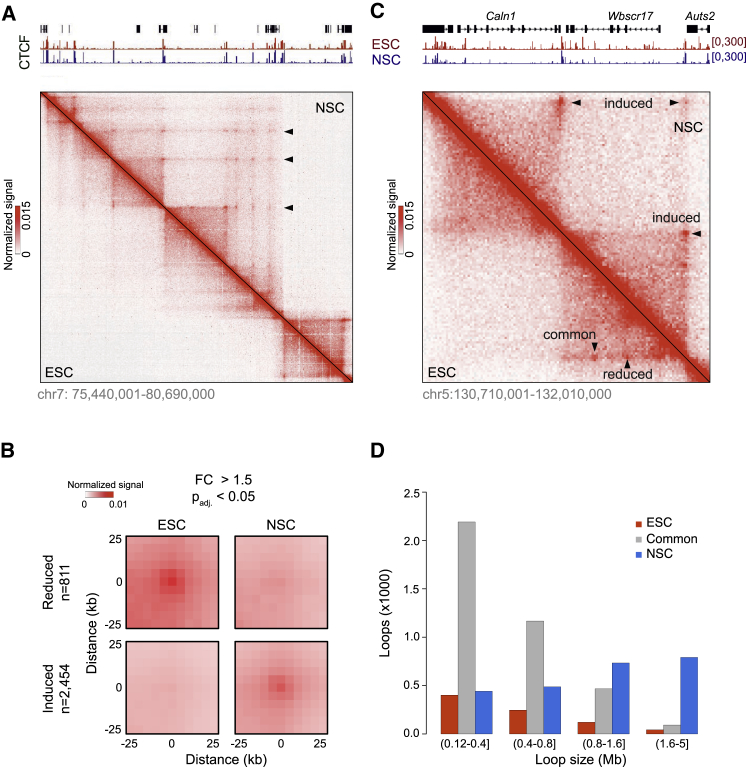
Differentiation Elicits Formation of Long-Range Chromatin Loops(A) Examples of chromatin loops (arrows) in ESCs and NSCs (lower and upper triangles, respectively). Heatmaps show normalized counts of in situ Hi-C reads between pairs of genomic loci (STAR Methods).(B) Composite profile of in situ Hi-C signal (similar to implementation of APA [Rao et al., 2014]) from reduced (top) and induced (bottom) loops in ESCs (left) and NSCs (right). Statistical significance of loop signal was assessed by a Wald test (FDR = 0.05 and FC > 1.5; STAR Methods).(C) Examples of dynamic and stable loops.(D) Length distributions of NSC-specific, common, and ESC-specific loops.